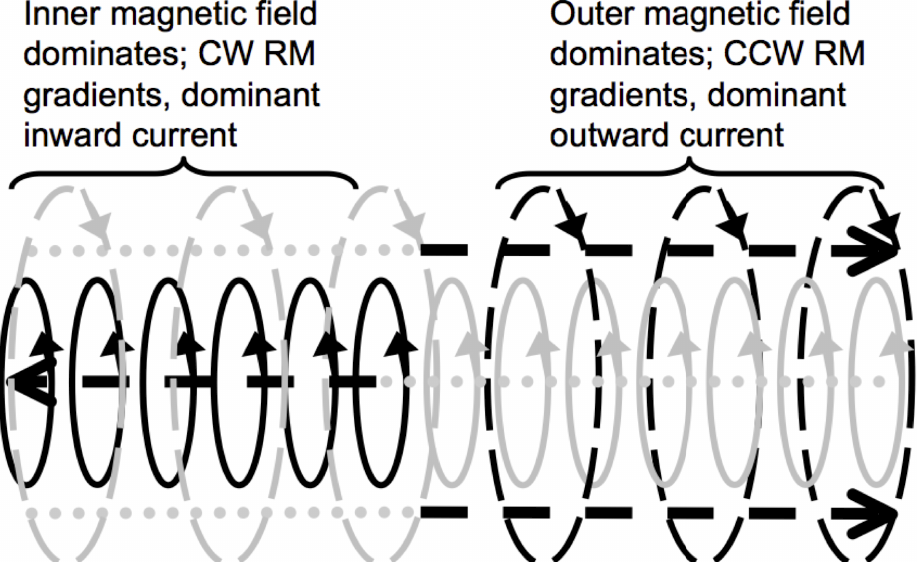
Figure 5. Schematic of a nested helical B field structure with its associated system of currents, with an inward current along the jet axis and an outward current further from the jet axis, associated with the “return” field. The jet propagates to the right, and the jet base is located to the left of the regions shown. The ellipses represent the azimuthal components of the fields; these are shown black and grey at distances where the inner and outer azimuthal fields dominate or do not dominate the observed transverse RM gradients. The orientations of the azimuthal fields are shown by arrows. The associated currents are shown by black dashed and grey dotted lines with arrows. Inward currents dominate on parsec scales, while outward currents dominate on decaparsec–kiloparsec scales. CW: clockwise; CCW: